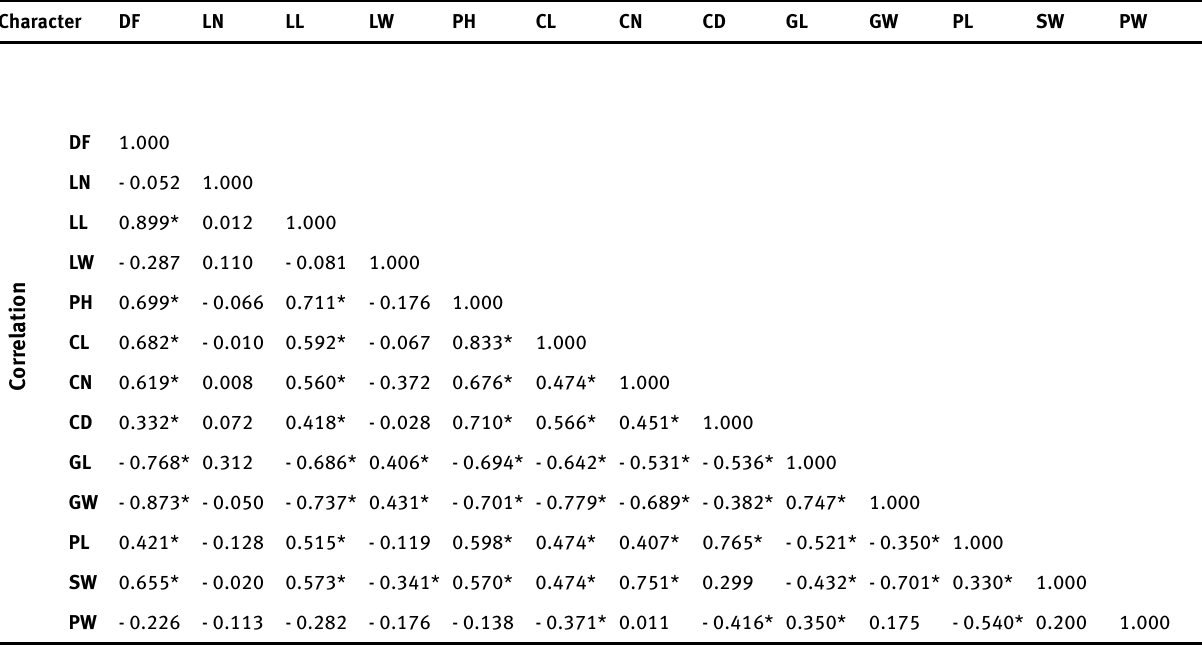
Table 5: Correlation among the quantitative characters within accessions of Pachchaperumal and Suduru samba